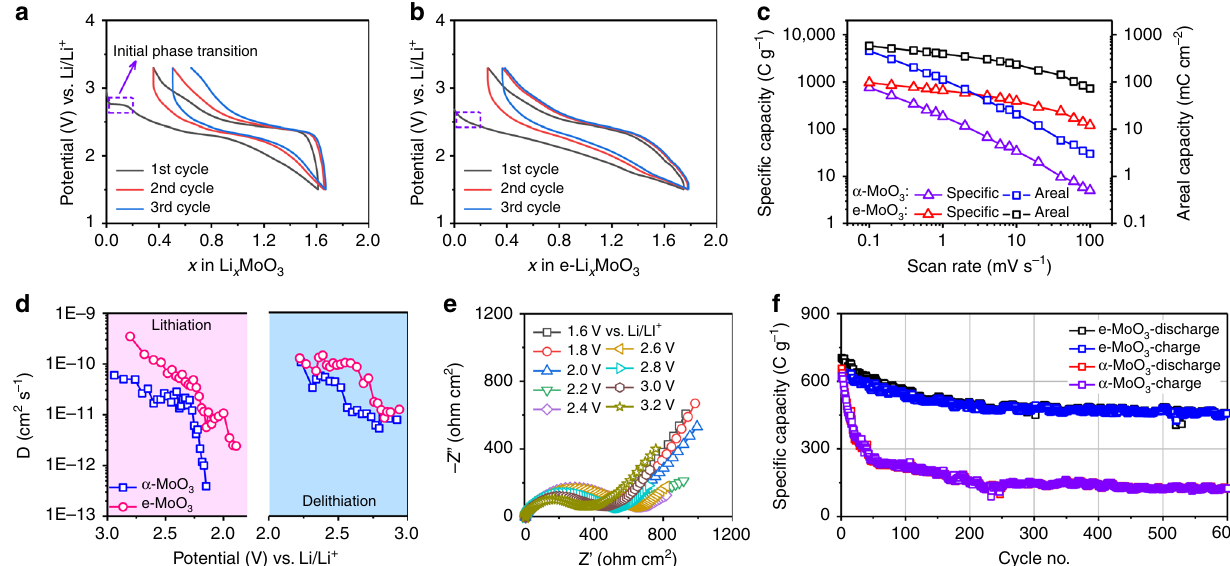
Fig. 2 Li + storage behavior of α -MoO 3 and e-MoO 3 electrodes. Initial three galvanostatic charge/discharge pro fi les of a α -MoO 3 and b e-MoO 3 electrodes. c Speci fi c and areal capacity as a function of scan rate. d Li + diffusion coef fi cient calculated from GITT curves. e Nyquist plots of e-MoO 3 at different potentials. f Cycling performance of α -MoO 3 and e-MoO 3 at 100 mA g − 1